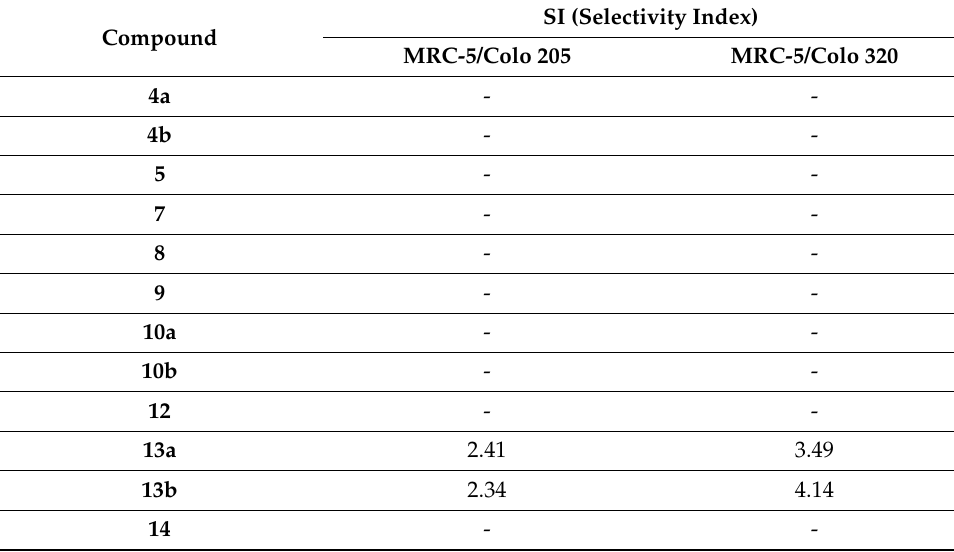
Table 3. The selectivity index of the synthesised compounds based on their IC 50